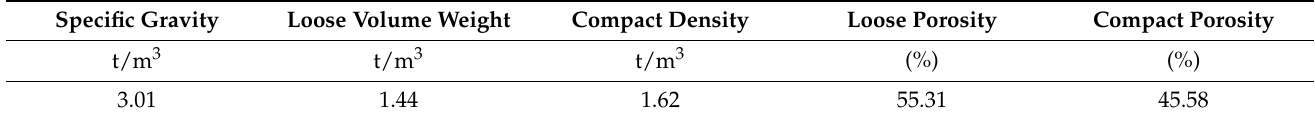
Table 1. Basic physical properties of unclassified